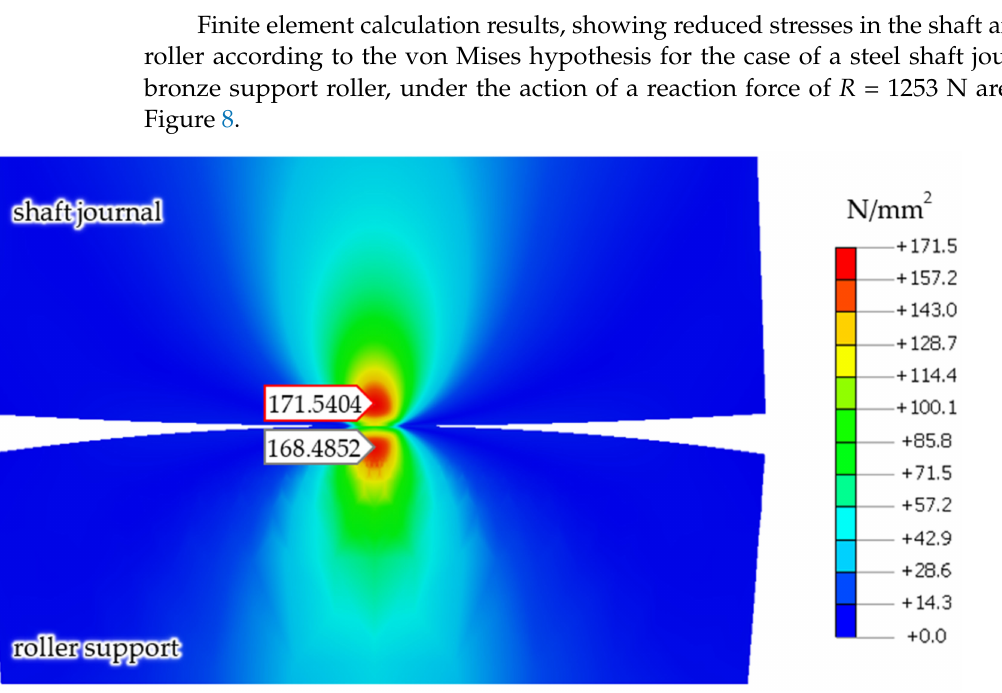
Figure 8. Calculations, showing reduced stresses in the shaft and support roller according to the von Mises hypothesis, for the case of a steel shaft and a support roller made of aluminum–bronze, under a reaction force of R = 1253